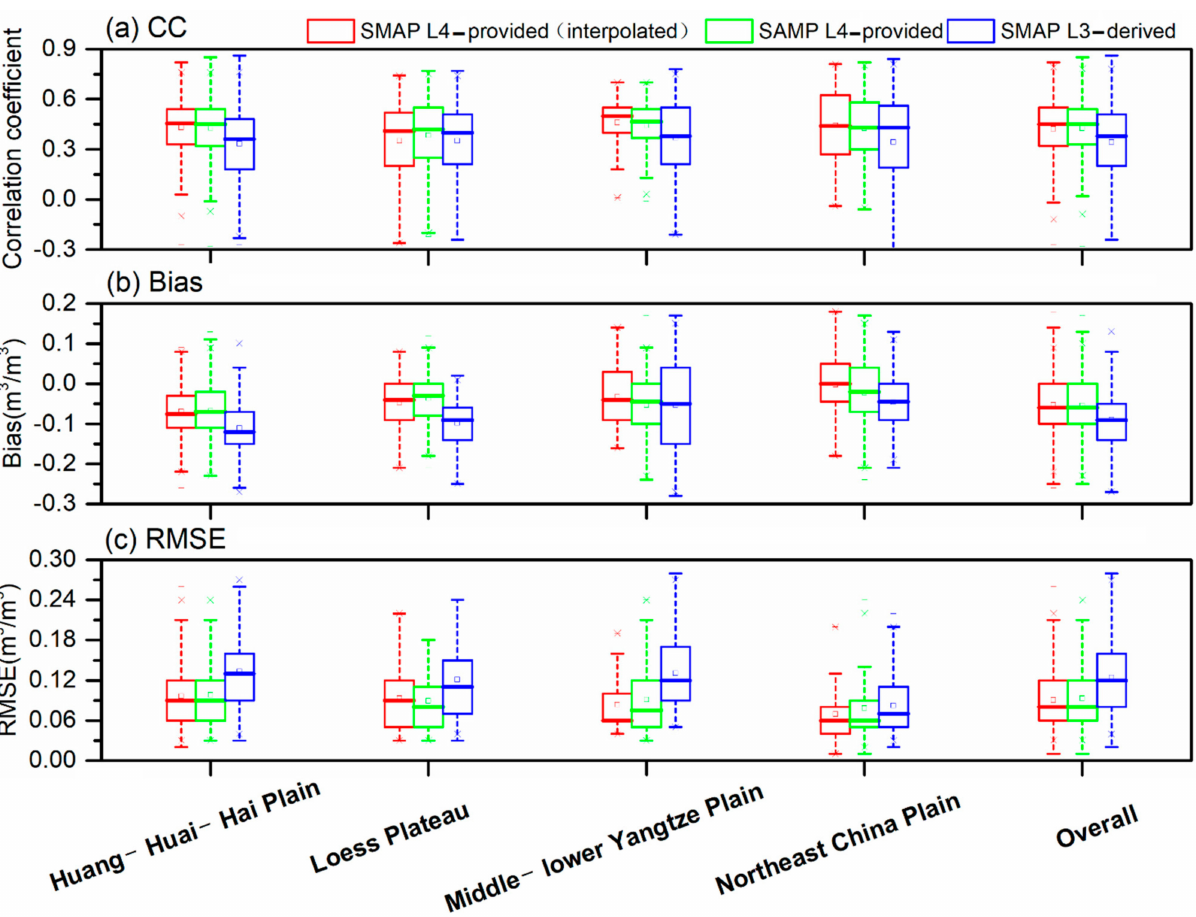
Figure 8. Distribution box diagrams of CC ( a ), bias ( b ), and RMSE ( c ) between SMAP L3-derived and SMAP L4-provided RZSMs and in situ ground observations among different agricultural zonings. Presented are the median, the 1st quantile Q1 and 3rd quantile Q3 (as indicated by the box), and the Q1 − 1.5(Q3 − Q1) and Q3 + 1.5(Q3 − Q1) values (whiskers). Moreover, the CC, bias and RMSE compared to the observed RZSM series between SMAP L3-derived and SMAP L4-provided (after interpolation) RZSM showed similar spatial distributions within the whole evaluated area (Figure 9). Particularly, SMAP L3- derived RZSM even outperformed the SMAP L4-provided products in the central part of Northeast China Plain (SMAP L3-derived CC: 0.49; SMAP L4-provided CC: 0.41), where the latter cannot cover at that